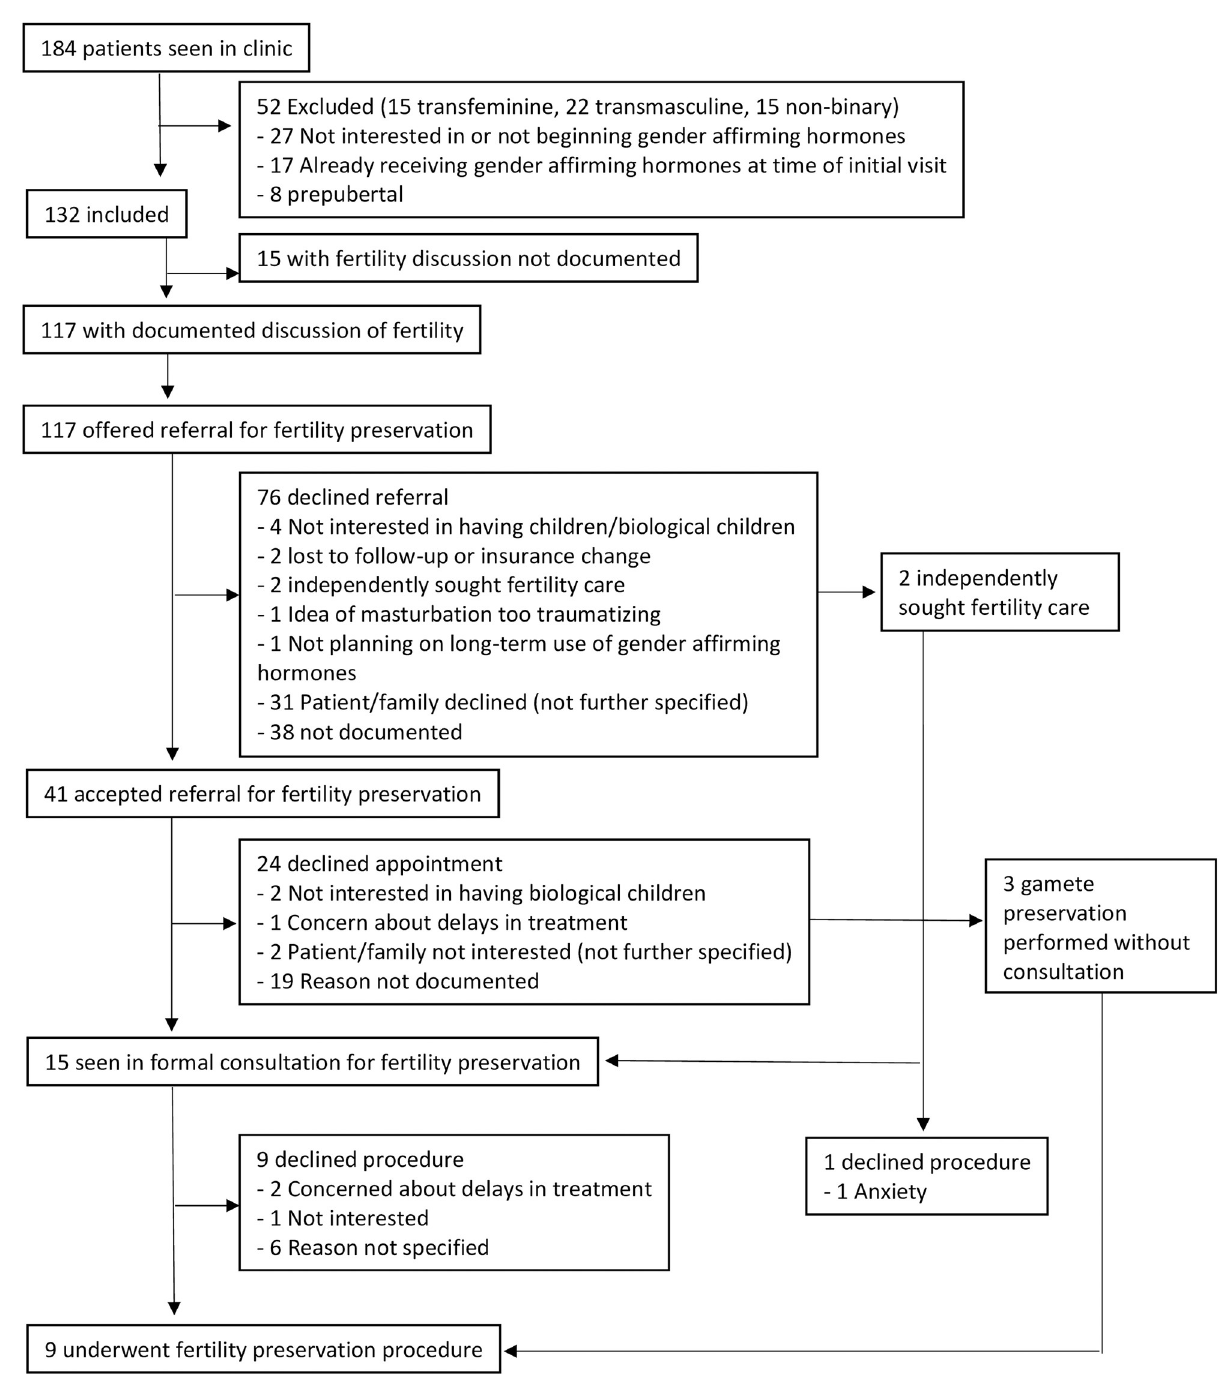
Fig 1. Study flow diagram. Outlines total individuals in study and participation in each step of fertility preservation pathway.